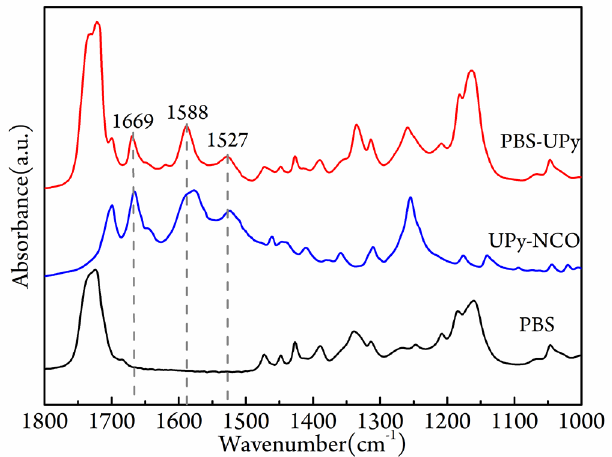
Figure 2. FTIR spectra of PBS-OH-4.4k, UPy-NCO and PBS-UPy-4.5k.